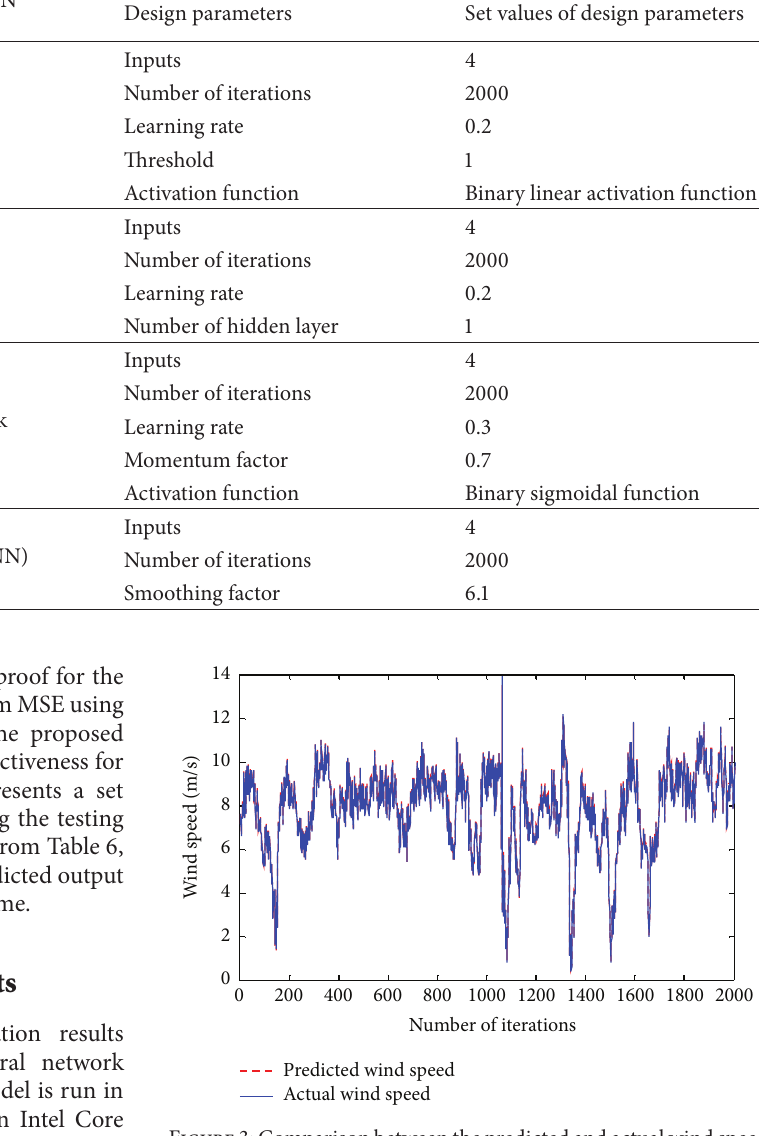
Figure 3: Comparison between the predicted and actual wind speed employing the proposed ensemble